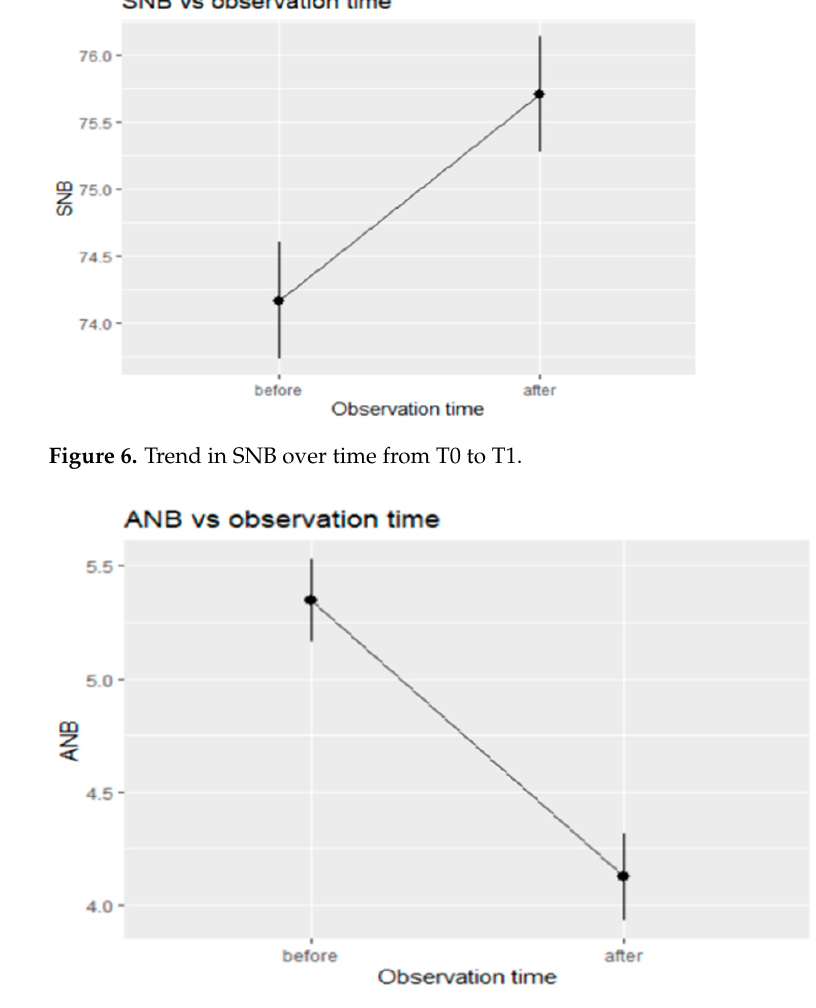
Figure 7. Trend in ANB over time from T0 to T1.